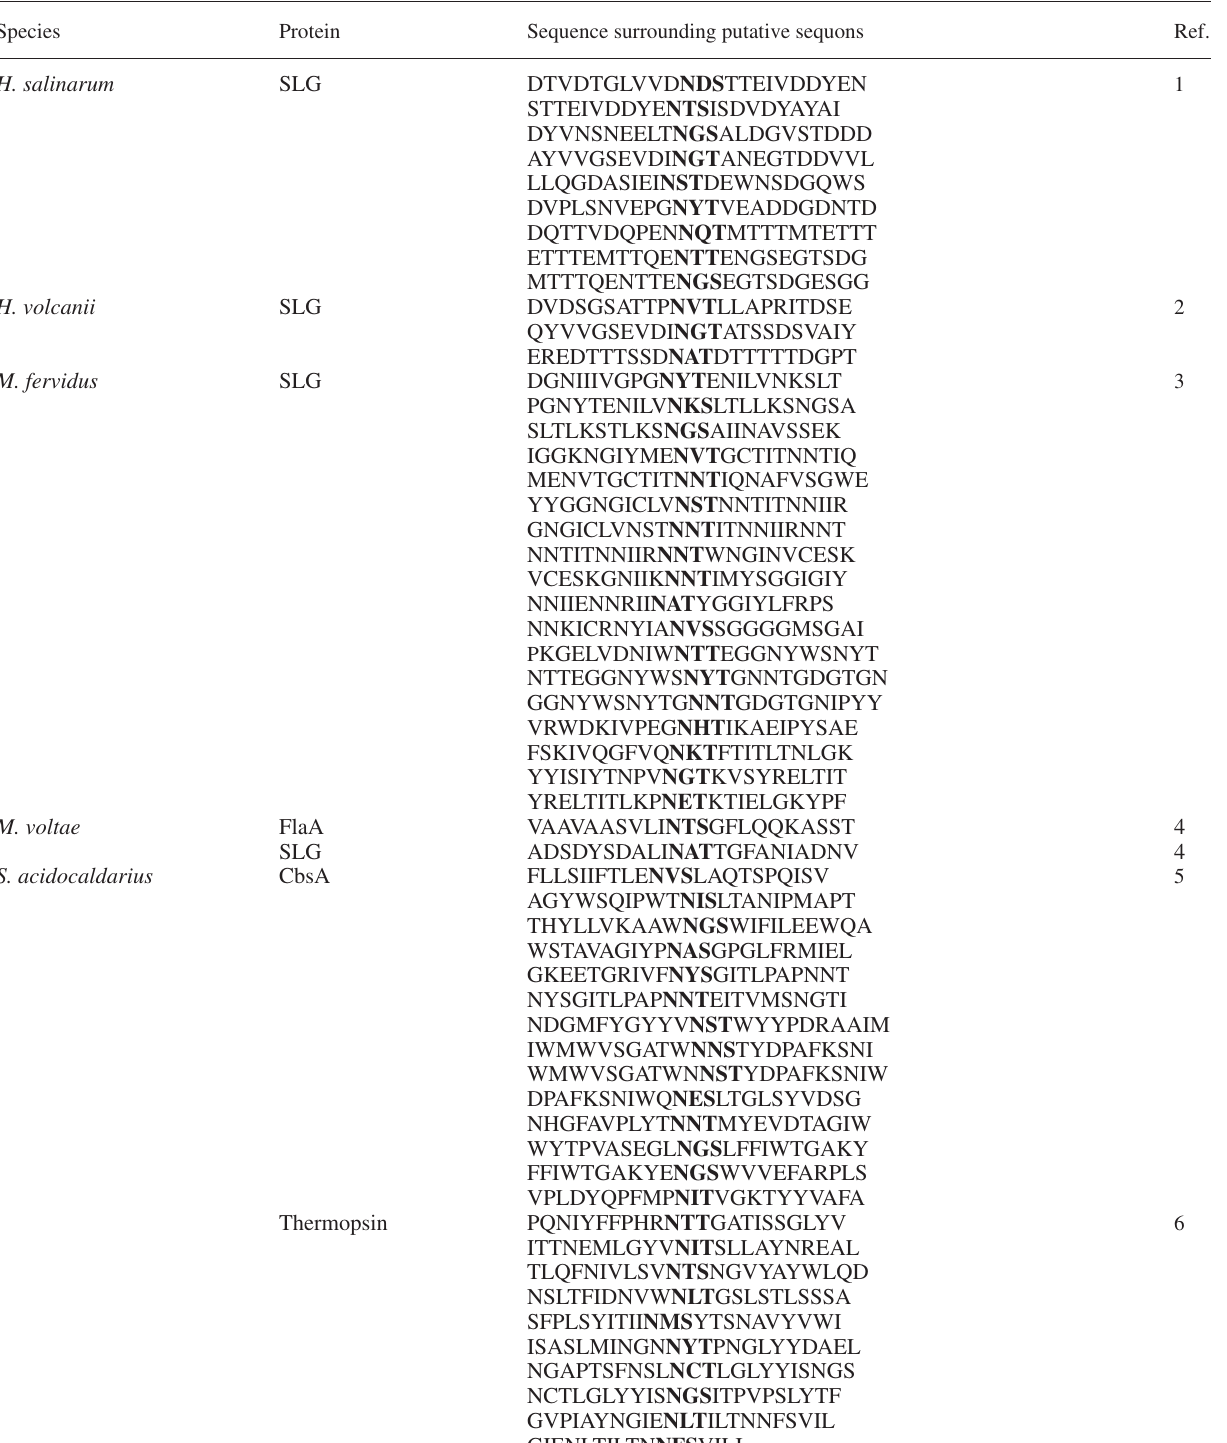
Table A1. Neighboring residues of putative sequons in archaeal glycoproteins containing experimentally verified N-glycosylated sequons. Refer- ences: 1 = Lechner and Sumper 1987; 2 = Sumper et al. 1990; 3 = Brockl et al. 1991; 4 = Voisin et al. 2005; 5 = Zahringer et al. 2000; and 6 = Lin and Tang 1990. Abbreviation: SLG = S-layer glycoprotein. Putative sequons are shown in bold. Species